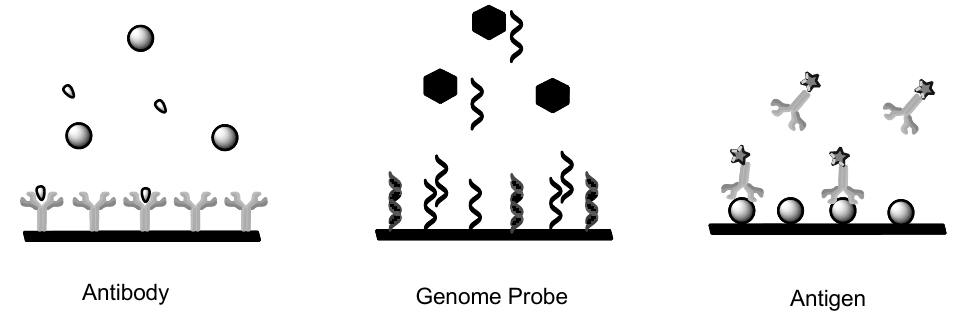
Figure 3. A schematic depicting antibodies and antigens as immunosensor prototypes and genome probe as genosensor prototype (Adapted from [53]).